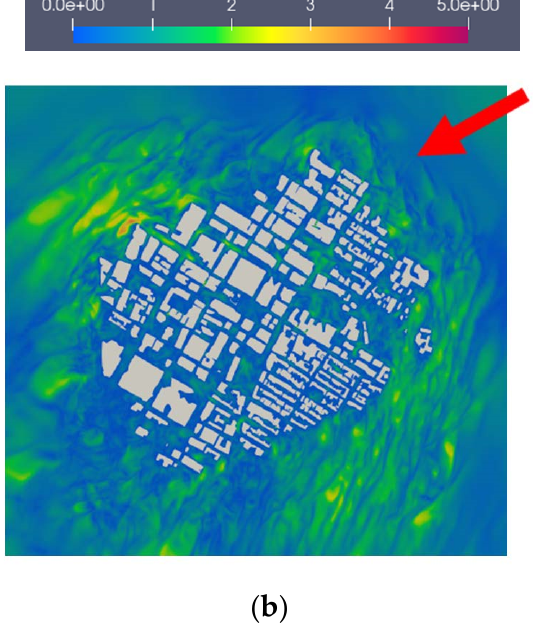
Figure 6. Numerical results of the case study, downtown Montreal, Canada (15 July 2013). ( a ) Daily velocity variation at the center of the case study. ( b ) Velocity distribution (m/s) at the pedestrian level height (2 m), 12:00 p.m. with the arrow showing the incoming wind direction.